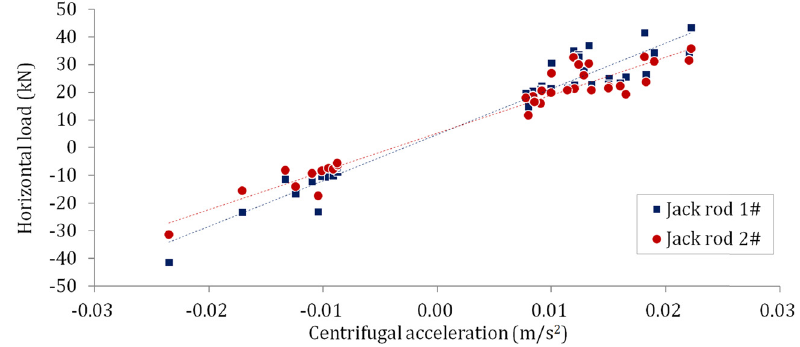
Figure 17: Mechanical relation between horizontal load and centrifugal